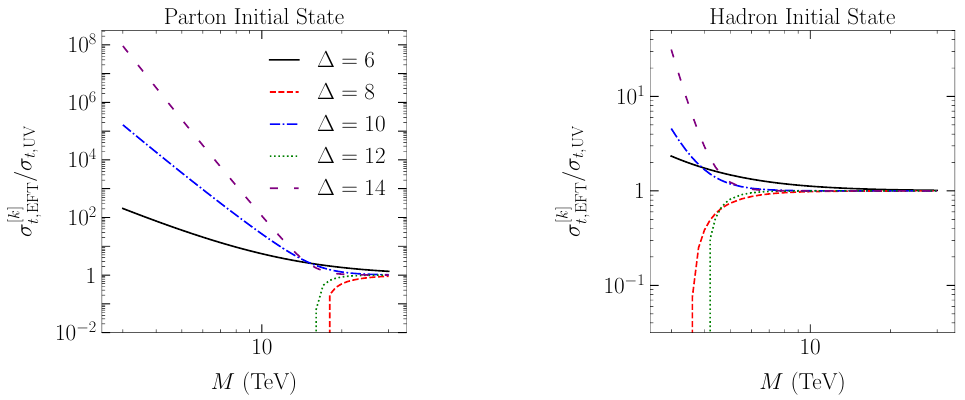
Figure 12 . The ratio σ [ k ] /σ t, UV for the first few ∆ = 6 + 2 k as a function of M . For the t, EFT “Partonic Initial State” case [left], the series converges for M > For the “Hadronic Initial State” case [right], the series converges for M > √ s (although it actually diverges for ∆ > ∆ crit ). converging when M .